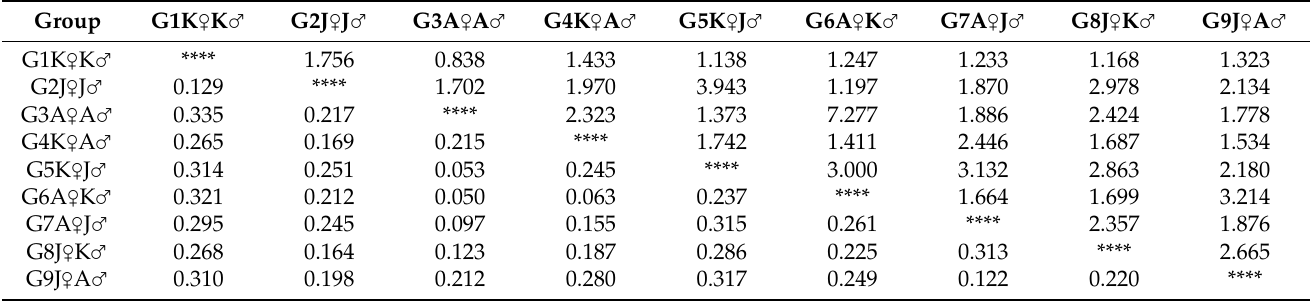
Table 6. Genetic variations at three microsatellite loci (Lr3, Lr24 and Lr27) in nine different groups of Ariza labeo ( L. ariza ). The single words picked to name the purebred and crossbred groups bear the full forms as G → Group, K → Kangsha River stock, J → Jamuna River stock and A → Atrai River stock.